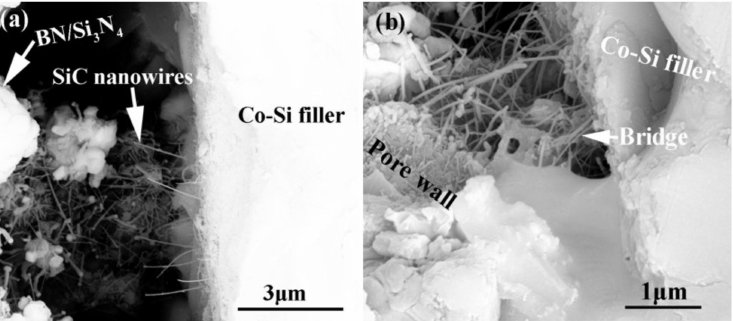
Figure 17. Connection form of the SiC nanowires in the joints. ( a ) SiC nanowires with different directions, ( b ) the formed